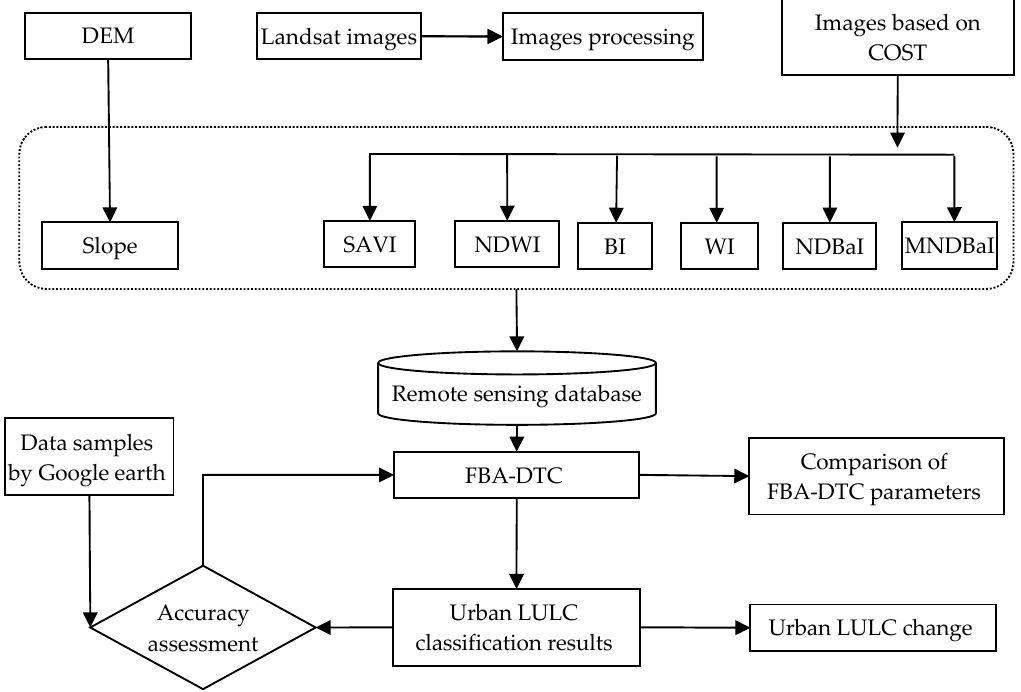
Figure 2. Flow chart used in the research. Notes: FBA-DTC is feature-based approach of decision tree classification; SAVI is soil adjusted vegetation index; NDWI is normalized difference water index; NDBaI is normalized difference barren index; MNDBaI is modified normalized difference barren Index; BI is brightness index; WI is wetness index.